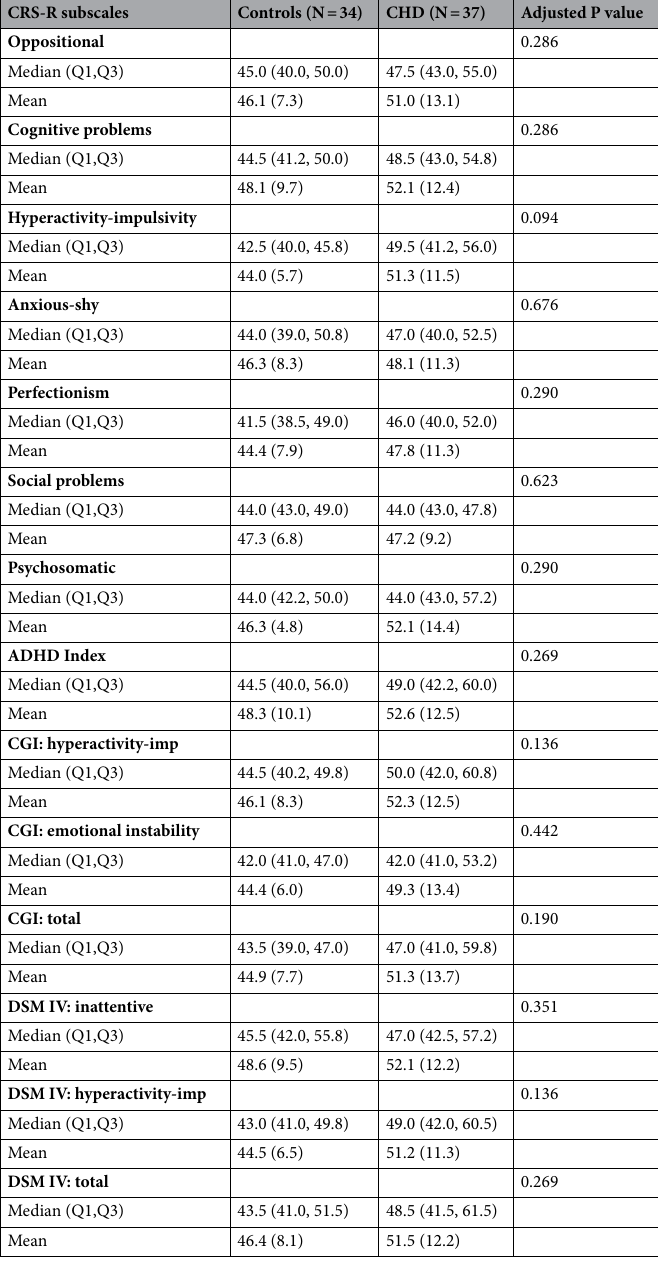
Table 4. CRS-R Median and mean scores in the two groups are reported. ADHD: attention deficit hyperactivity disorder; CGI: clinical global index; DSM: diagnostic and statistical manual of mental